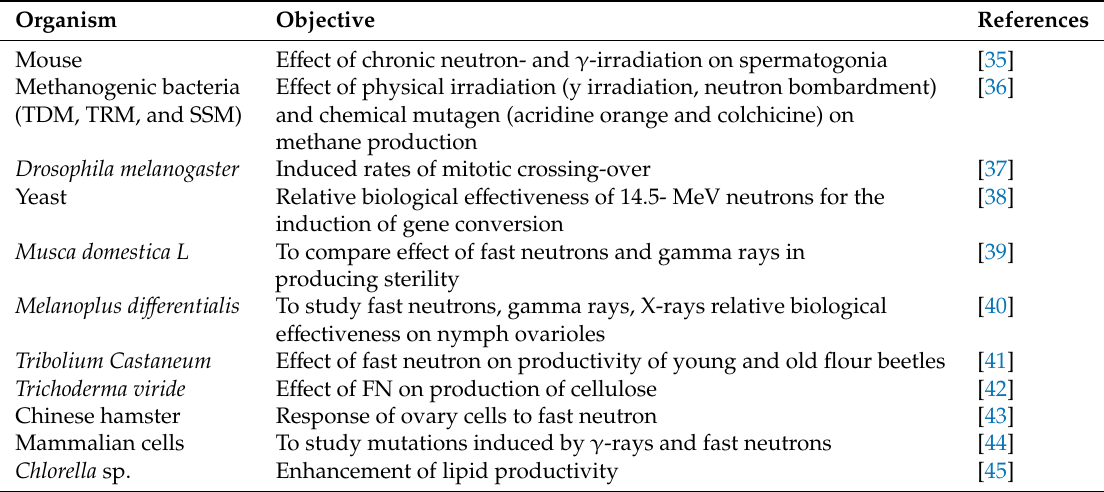
Table 2. Study of fast neutron mutagenesis in di ff erent organisms.